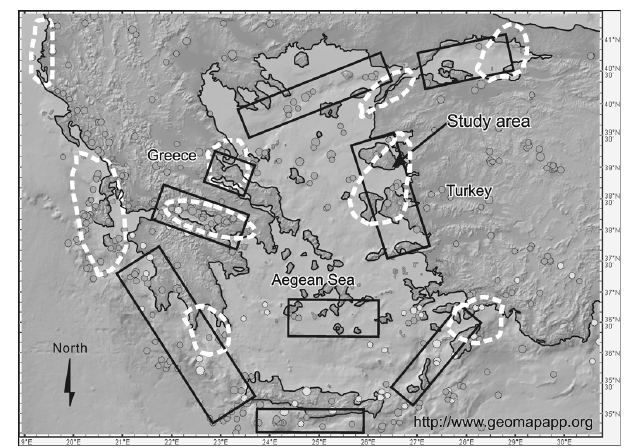
Fig. 4. Tsunamogenic zones in the broad Greek area. Black squares are redrawn after Papadopoulos and Foakefs (2005) and Yolsal et al. (2007) whereas white dashed lines after Papadopou- los and Chalkis (1984). Dots indicate location and epicenter depth (grey ≤ 50km; white 50–200km) of recent earthquakes ( M ≥ 5; 1964–1995) modified from